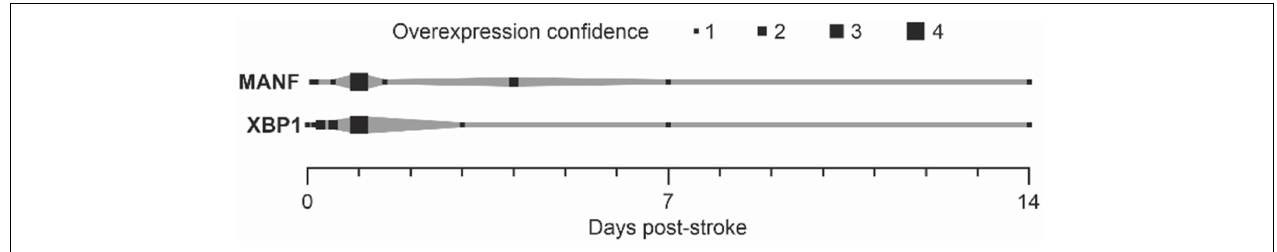
FIGURE 4 | Upregulation of MANF and XBP1 after stroke. “Overexpression confidence” = number of publications showing the upregulation of MANF or XBP1 after stroke (references: Tables 1 , 2 ).